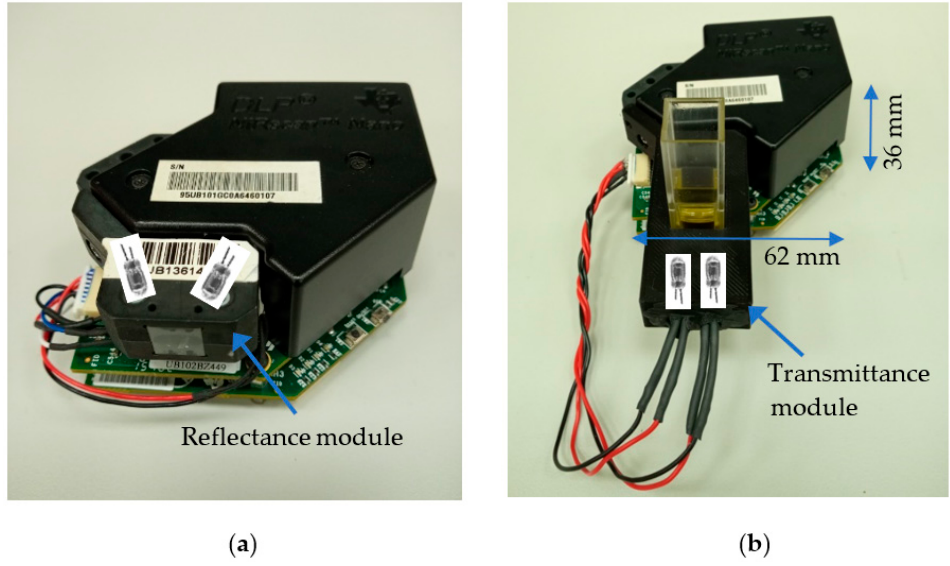
Figure 4. DLP NIRscan Nano EVM with ( a ) reflective module and ( b ) transmittance module.